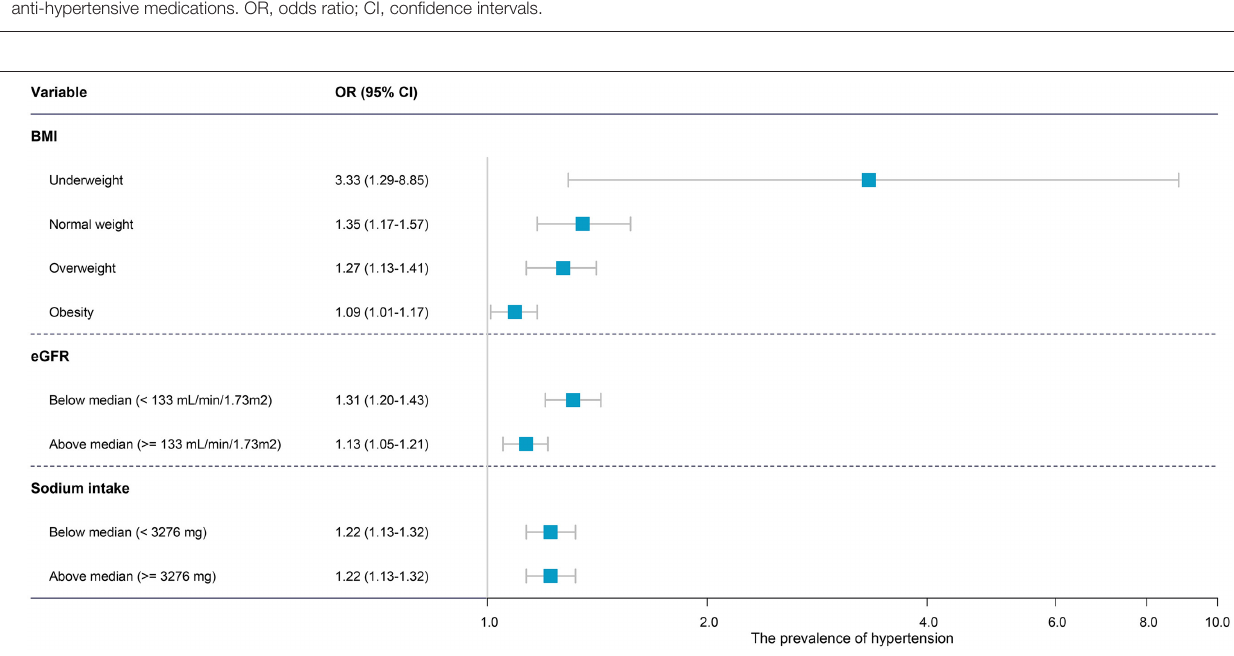
FIGURE 2 | Restricted cubic spline plots of the association between waist circumference and (pre) hypertension in (A) males and (B) females. The association was adjusted for body mass index, age, sex, race/ethnicity, education levels, diabetes history, smoking status, alcohol consumption, height, and administration of anti-hypertensive medications. OR, odds ratio; CI, confidence intervals.